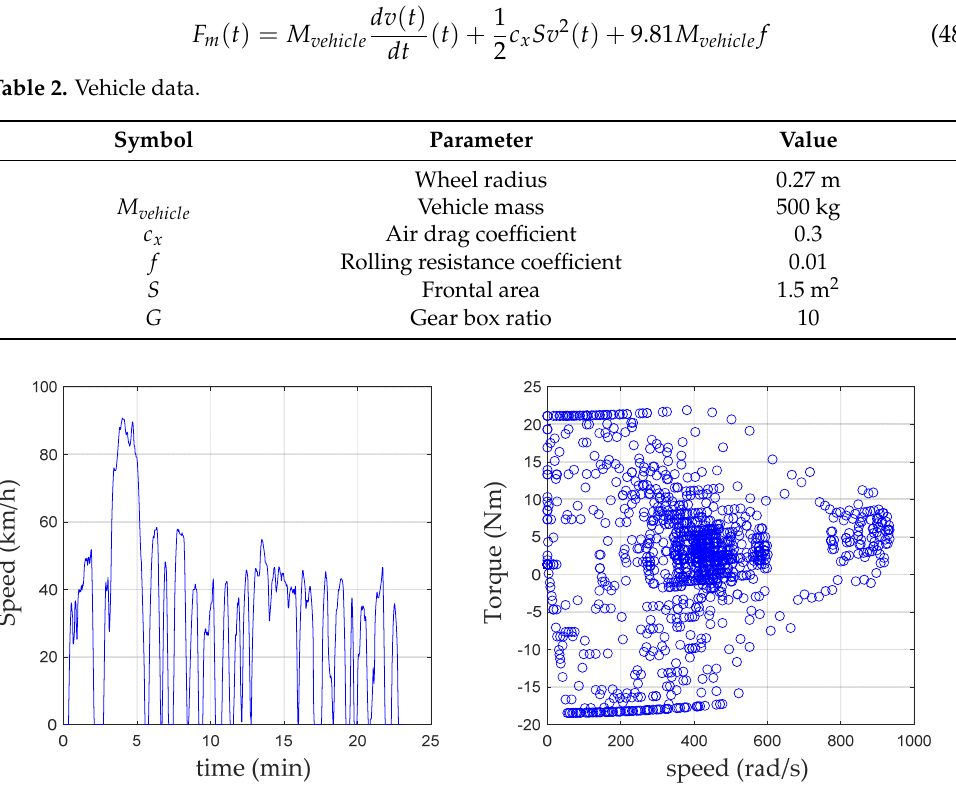
Figure 6. Speed and torque to the wheel profiles.